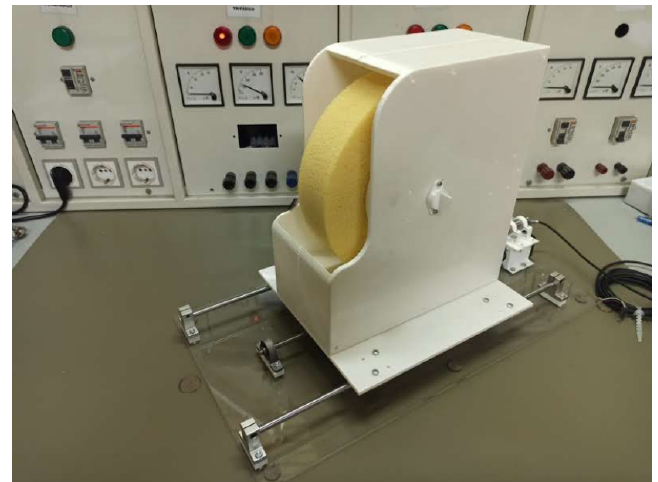
Figure 20. Full application